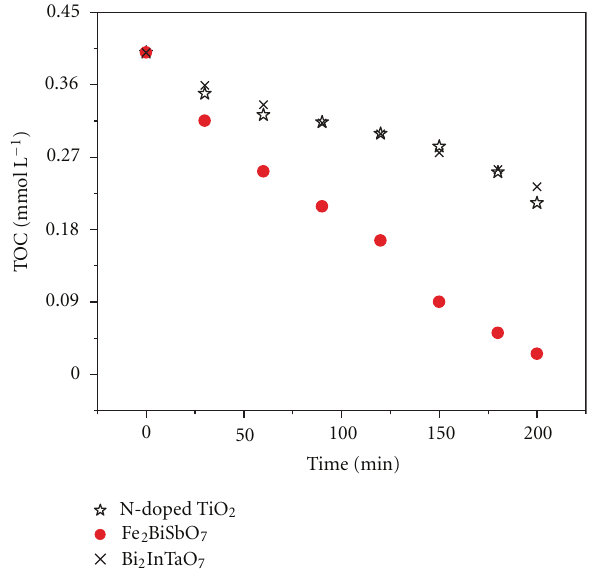
Figure 4: Disappearance of total organic carbon (TOC) during photocatalytic degradation of methylene blue with Fe 2 BiSbO 7 , Bi 2 InTaO 7 , or N-doped TiO 2 as catalyst under visible light irradi- ation.